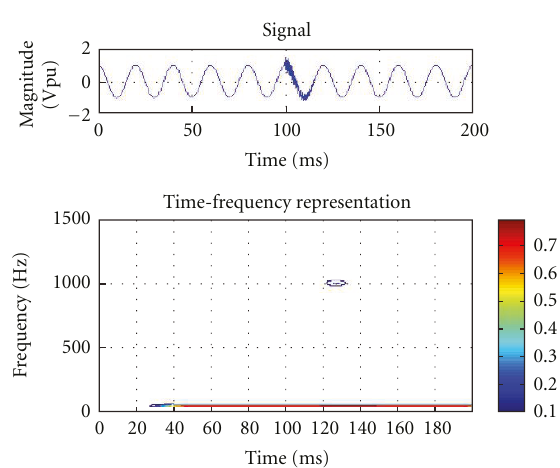
Figure 15: The TFR of transient signal using MBD at β = 1 .